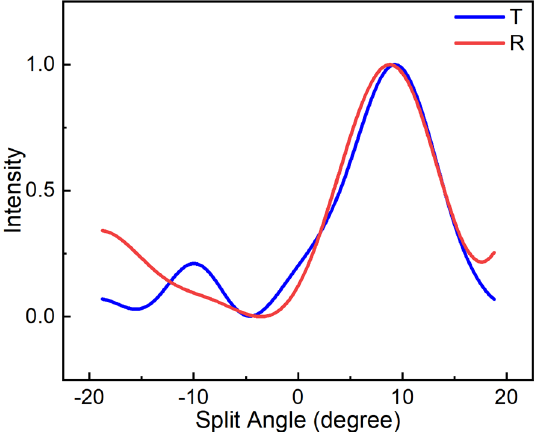
Figure 8. The double-ended normalized intensity distribution at di ff erent emergence angles.